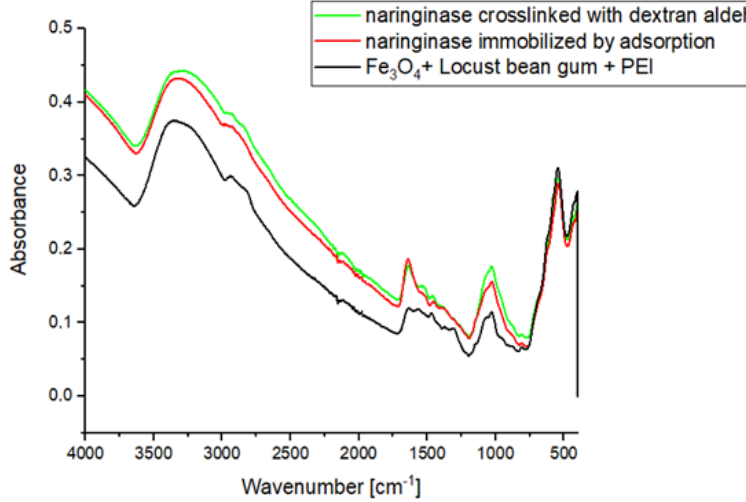
Figure 2. IR ATR spectrum of the magnetic polysaccharide carrier activated by polyethyleneimine, naringinase immobilized by adsorption on the carrier and crosslinking with dextran aldehyde. Additional binding of the enzyme to the carrier with dextran aldehyde has many advantages.